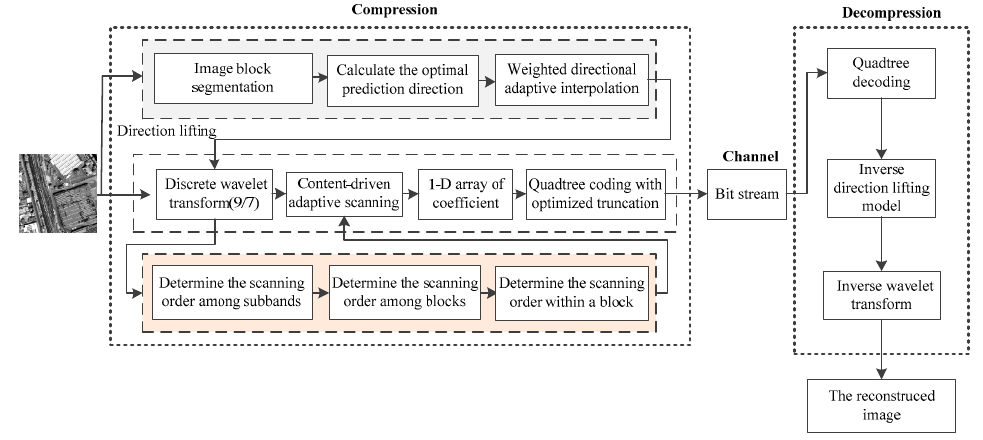
Figure 1. The overall framework of the proposed compression method.